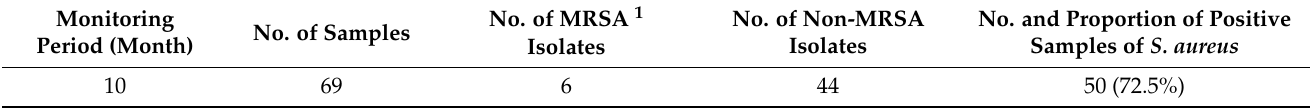
Table 2. Prevalence of S. aureus in raw milk of artisanal dairy retail stores in Hefei, China. Monitoring No. of MRSA No. of Samples Period (Month)